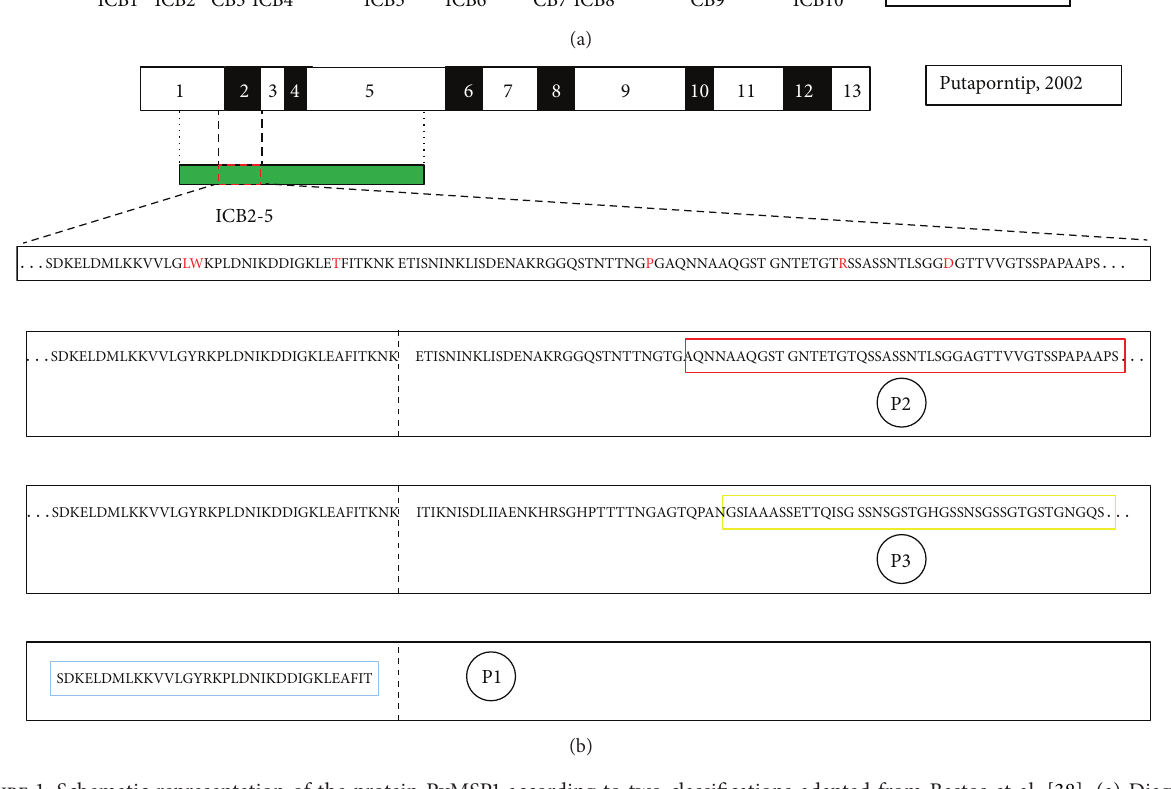
Figure 1: Schematic representation of the protein PvMSP1 according to two classifications adapted from Bastos et al. [38]. (a) Diagram showing the division of PvMSP-1 into interspecies conserved blocks (ICBs) among P. falciparum , P. vivax , and P. yoelii (blank), blocks conserved between P. falciparum and P. vivax (in gray), and polymorphic blocks (black), by Del Portillo et al. [39]. Another scheme showing the division of PvMSP-1 in 13 blocks, 7 conserved blocks (blank), and six polymorphic blocks (black) by Putaporntip et al. [40]. (b) Location and amine acids sequences of three recombinant proteins correspondent to Block-2 variants of PvMSP-1; (P1) conserved region located upstream of Block2; (P2) corresponding to the repeats of haplotype belem ; and (P3) corresponding to the repeats of another haplotype of Pv-MSP1 Block 2 circulating in Manaus